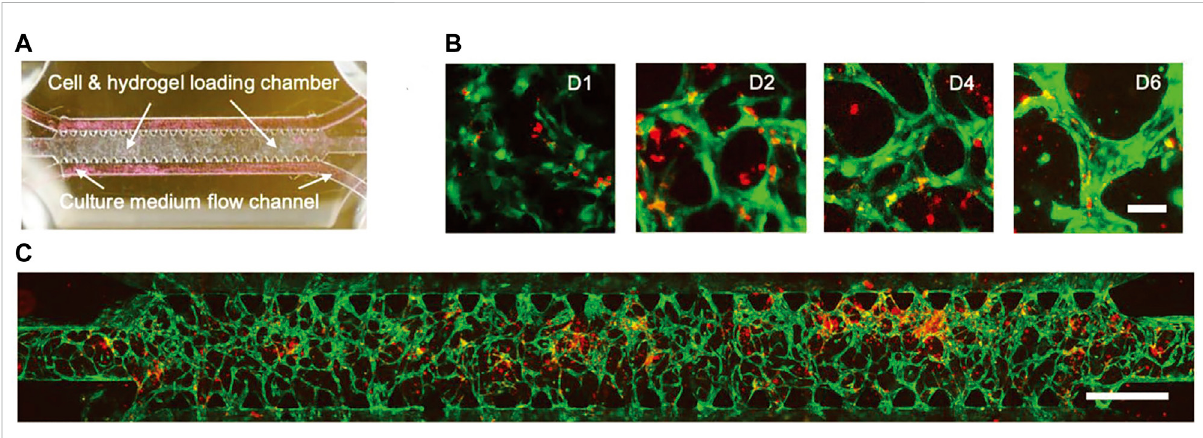
FIGURE 4 Perfusable vascularized glioblastoma model for dynamic localization and live cell imaging of individual brain tumor cells near microvessels. (A) Micro fl uidic device containing a cell/gel loading microchamber and media fl ow channels on both sides; (B,C) Microvessel formation and loading of individual BTSCs. Green: GFP-HUVECs. Red: BTSCs. Adapted under the terms of the Creative Commons Attribution License (CC BY). (https:// creativecommons.org/licenses/by/4.0/).(Xiaoetal.,2019)Copyright2019TheAuthors.PublishedbyWILEY-VCHVerlagGmbHandCo.,KGaA,